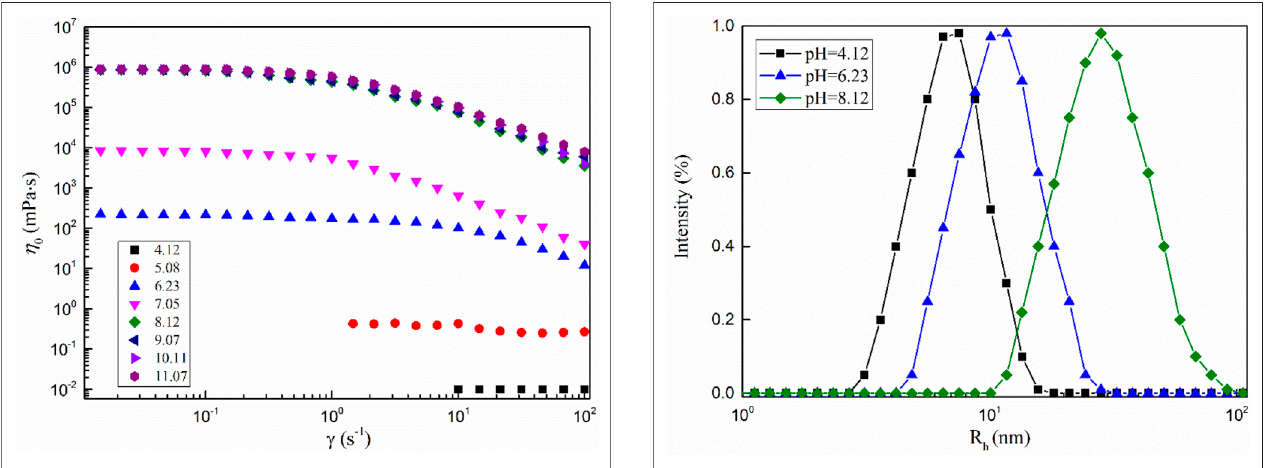
FIGURE 9 | Hydrodynamic radius of the MSA/CTAB mixed solution under different pH conditions.